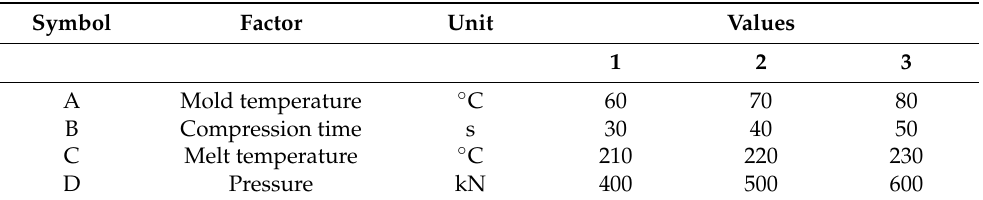
Table 3. Level of factors affecting the compression molding process.